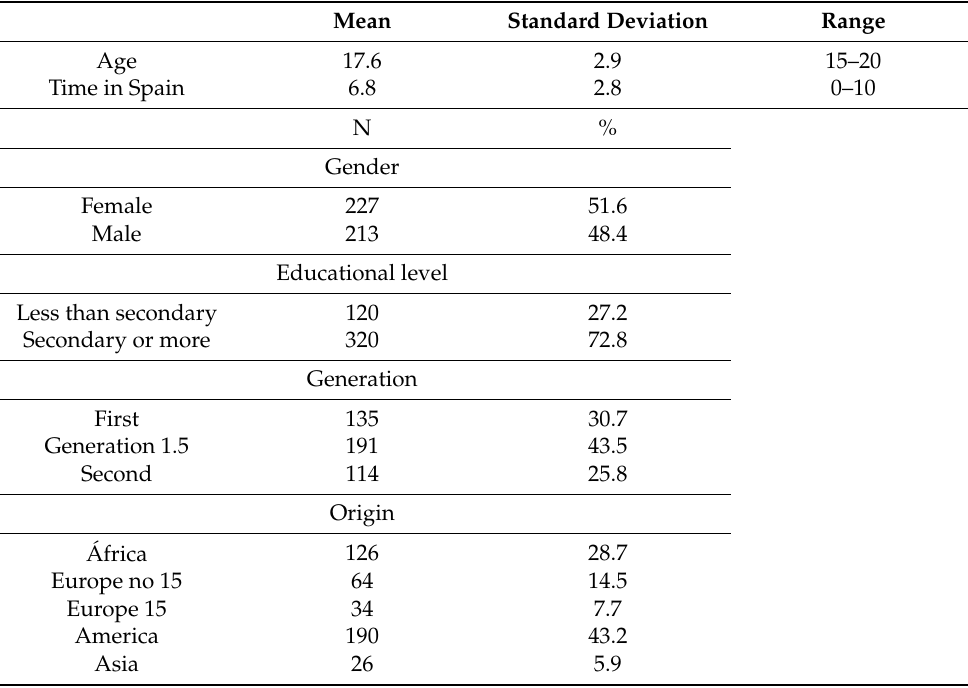
Table A1. Basic data of the research screening sample.